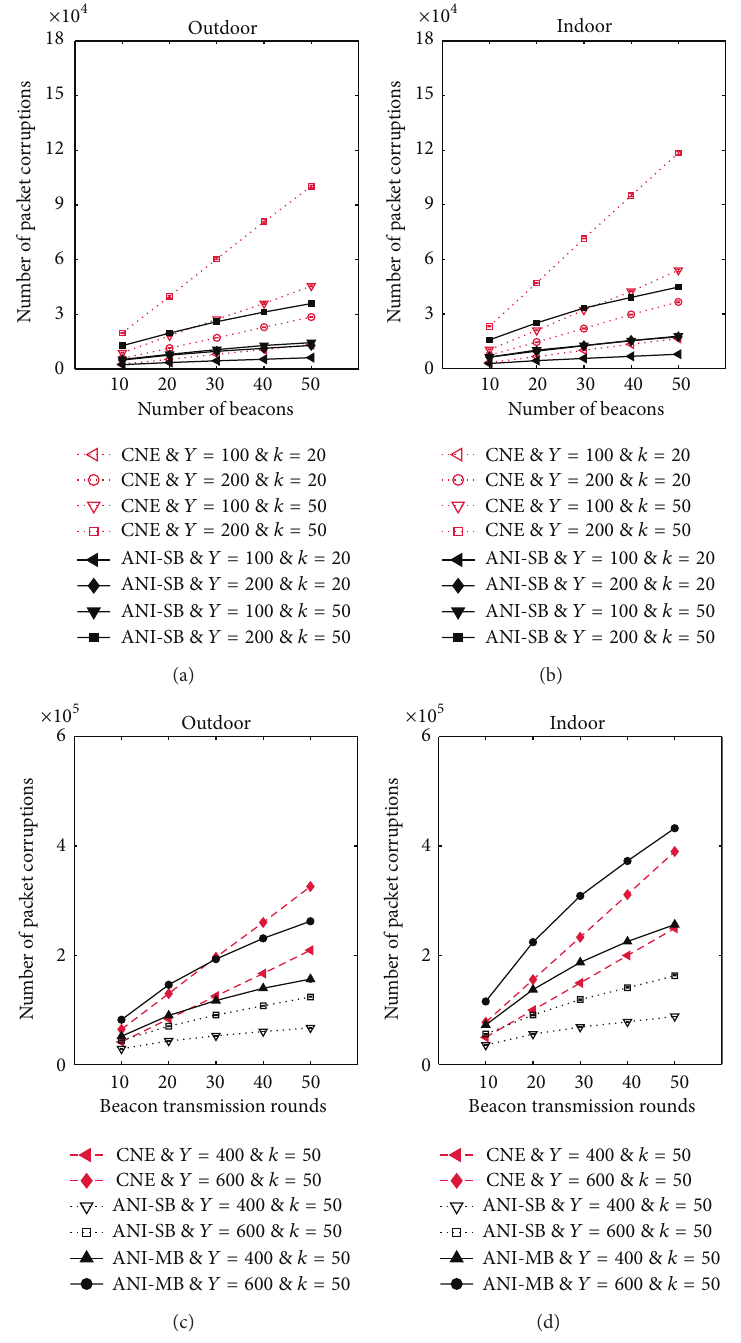
Figure 10: Number of packet corruptions by ANI-SB, ANI-MB, and CNE in multihop topology networks deployed in outdoor and indoor